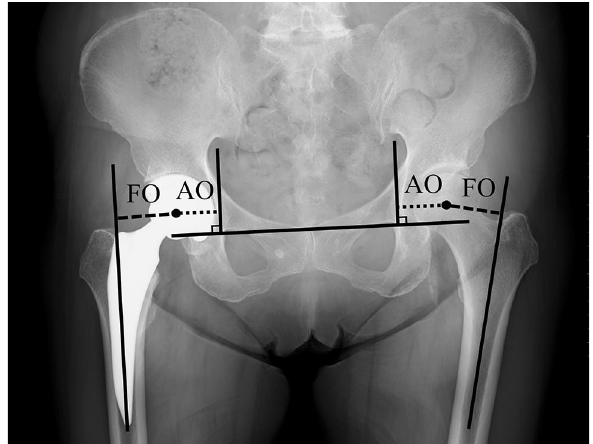
Figure 2. Assessment of acetabular offset (AO) and femoral offset (FO) using the 2D method.